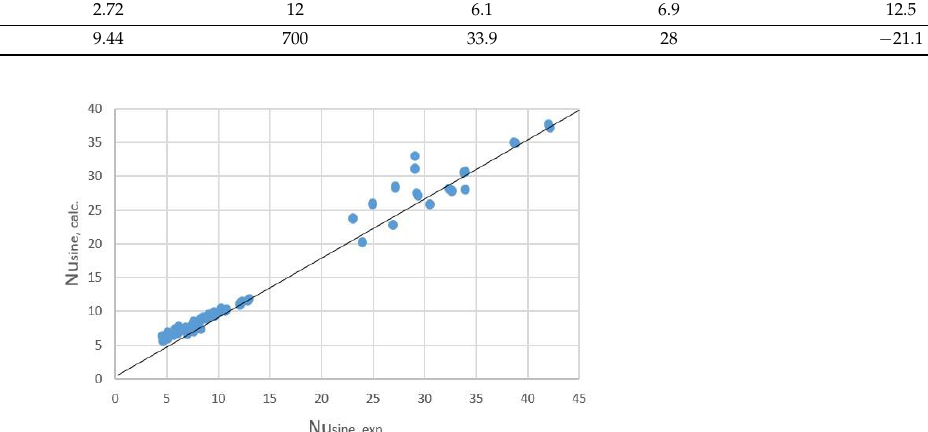
Figure 3. Comparison between the experimental Nu sine values and those computed with the model (Equation (10)).